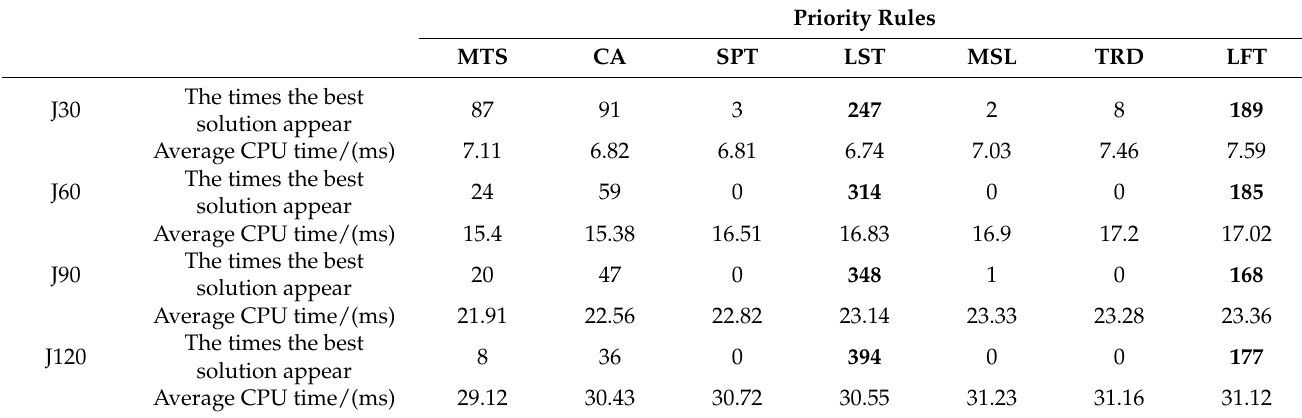
Table 4. Results of the serial schedule scheme-based methods.